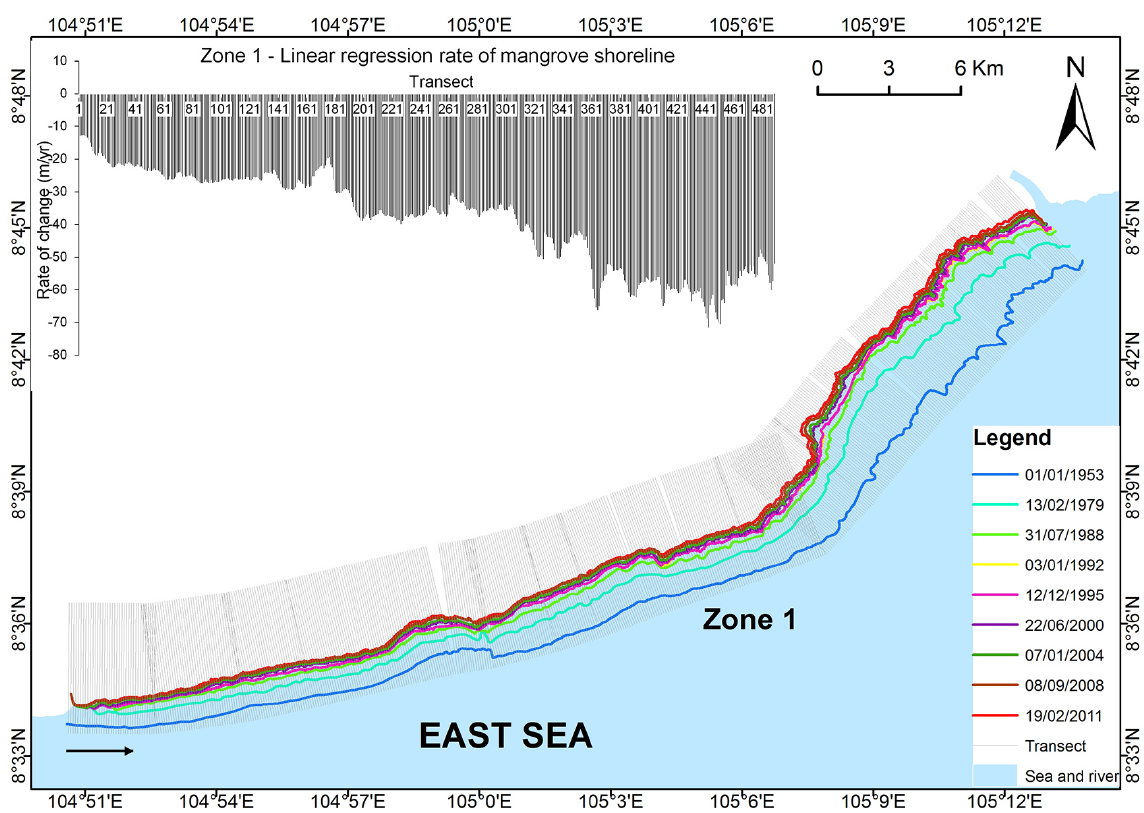
Figure 2. Mangrove shoreline changes in zone 1 which is located between Bo De and O Ro river mouths, along the East Sea. DSAS software generated 489 transects. The arrow shows the direction of transects from 1 to 489 which have a linear regression rate illustrated in the graph at the top left